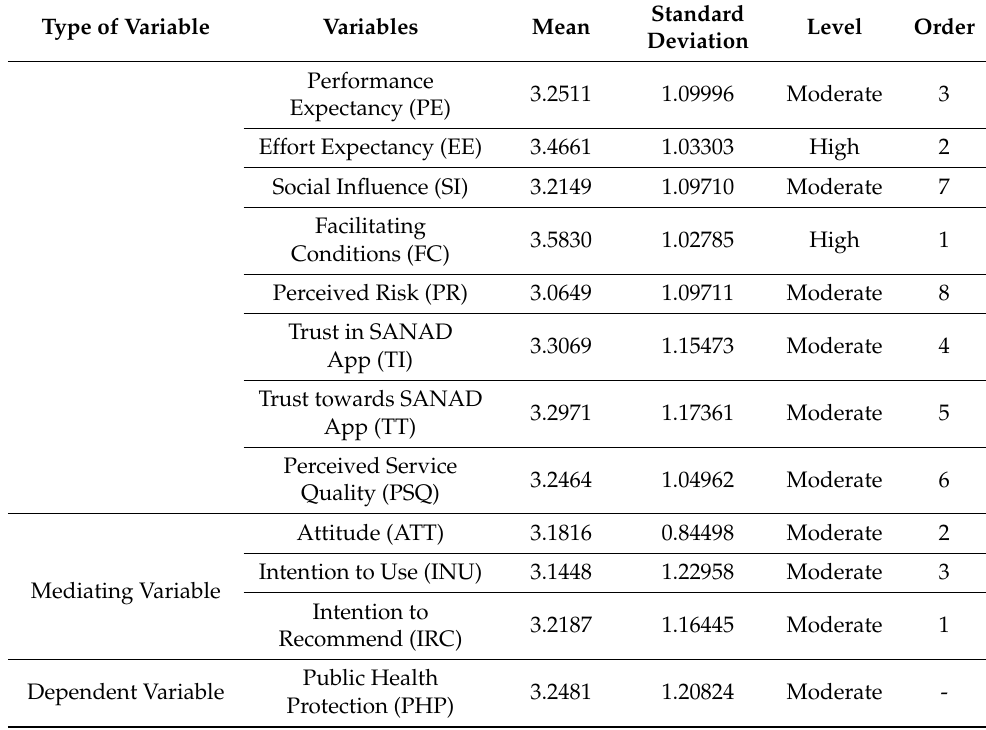
Table 2. Overall mean and standard deviation of the study’s variables.